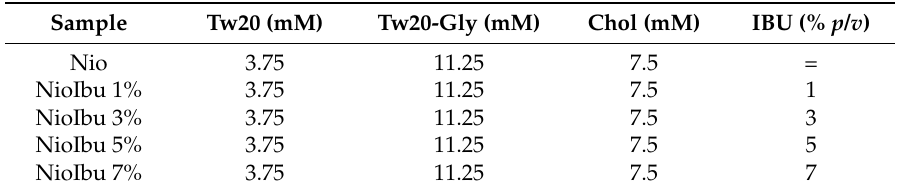
Table 1. Sample composition (NioIbu 5% has been the analyzed formulation). Nio, pH-Tw20Gly niosomes; NioIbu, pH-Tw20Gly niosomes loaded with different percentages of Ibuprofen Hepes solutions. Tw 20, is for Tween 20; Chol, is for Cholesterol; IBU, is for